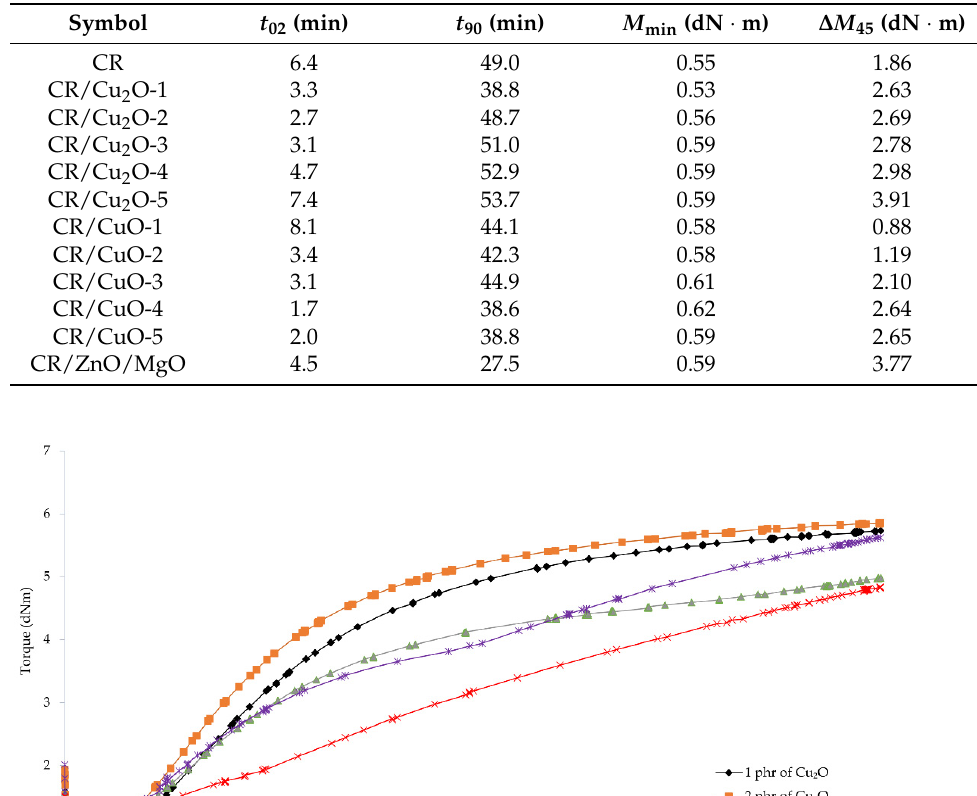
Table 2. Vulcametric parameters of the tested compositions determined at the temperature 160 °C.